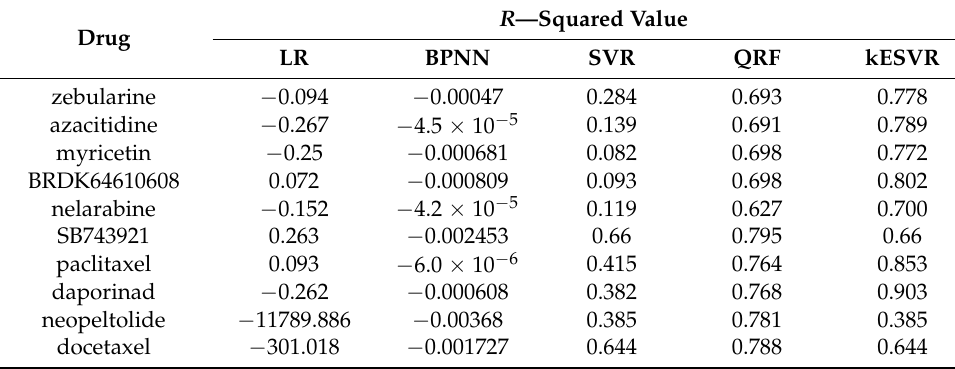
Table 8. Model Fitness Comparison using R-squared